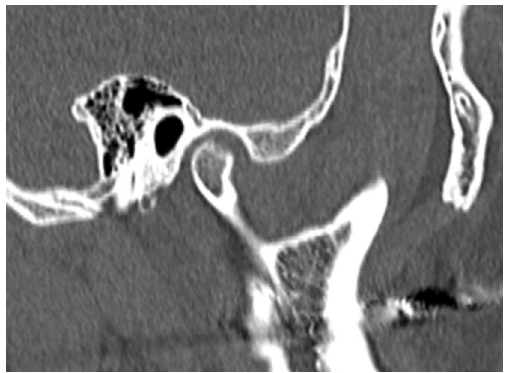
Figure 1. Sagittal cuts of CT which showed erosive osseous changes of